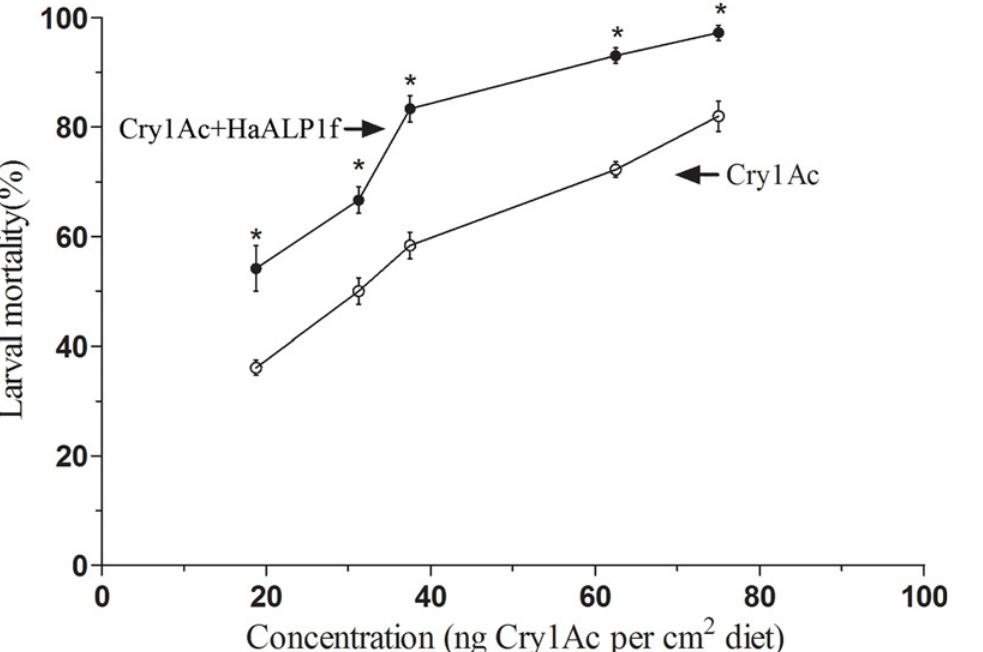
Fig 8. Effect of HaALP1f on toxicity of Cry1Ac activated toxin to a susceptible strain (96S) of H . armigera . The ratio of HaALP1f:Cry1Ac was 15:1 by weight. Asterisks denote significantly higher mortality with a mixture of HaALP1f and Cry1Ac than with Cry1Ac alone (P < 0.05) at a particular concentration of